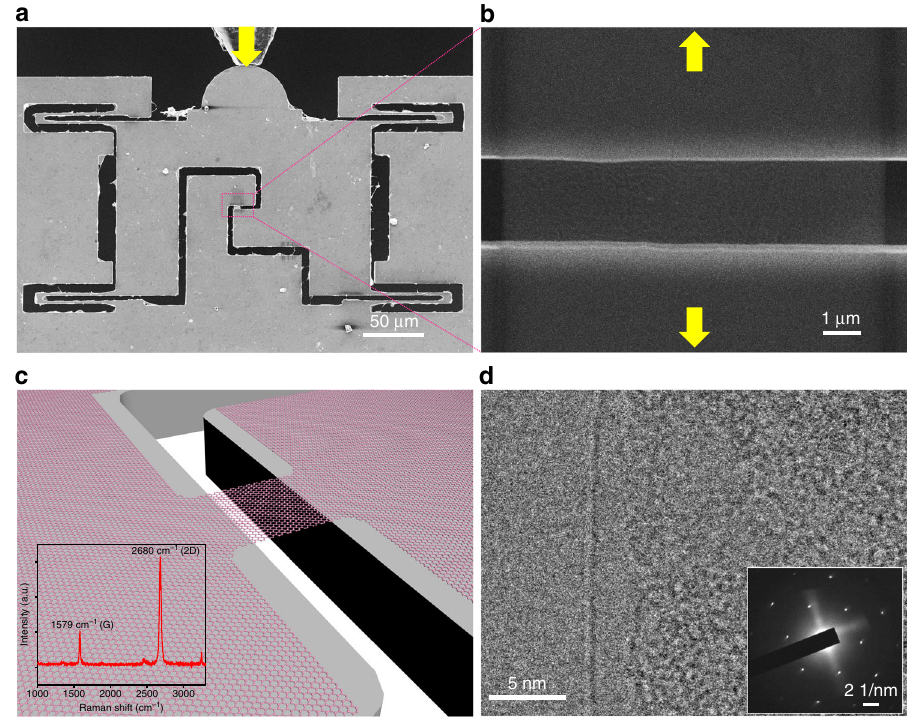
Fig. 1 Experimental setup and characterization of free-standing graphene. a In situ scanning electron microscope (SEM) tensile testing of a single- crystalline suspended graphene sample based on a push-to-pull (PTP) micromechanical device actuated by an external quantitative pico-indenter, the yellow arrow indicates the indentation direction during a tensile testing process. b Zoom-in view of the pink rectangle area in a showing a suspended graphene ribbon sample, whereas the yellow arrows indicate the tensile loading direction. c Illustration of a free-standing graphene ribbon sample suspended between the device gap. The inset in c shows Raman characterization of the monolayer graphene sample, the ratio of 2D to G is ~3. d TEM characterization of the edge of the suspended sample, inset showing the single-crystalline SAED pattern.